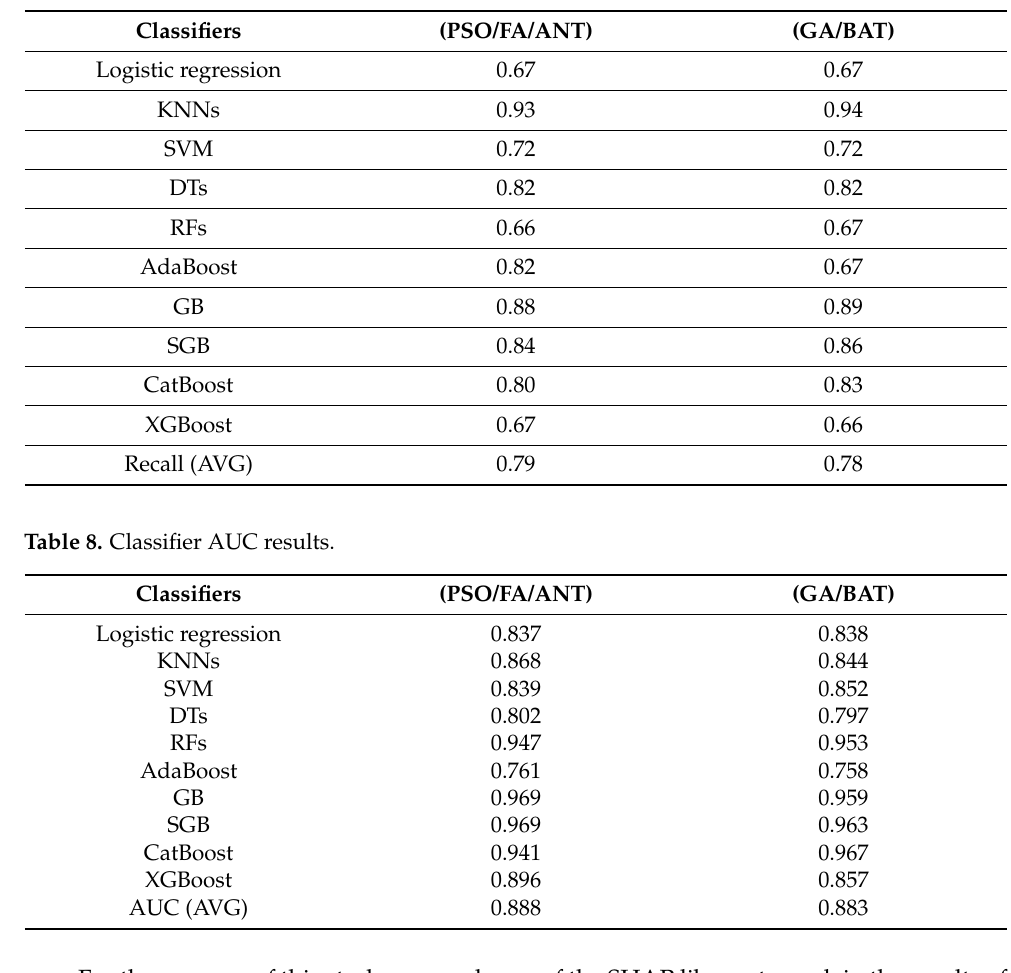
Table 7. Classifier performance using recall metric.